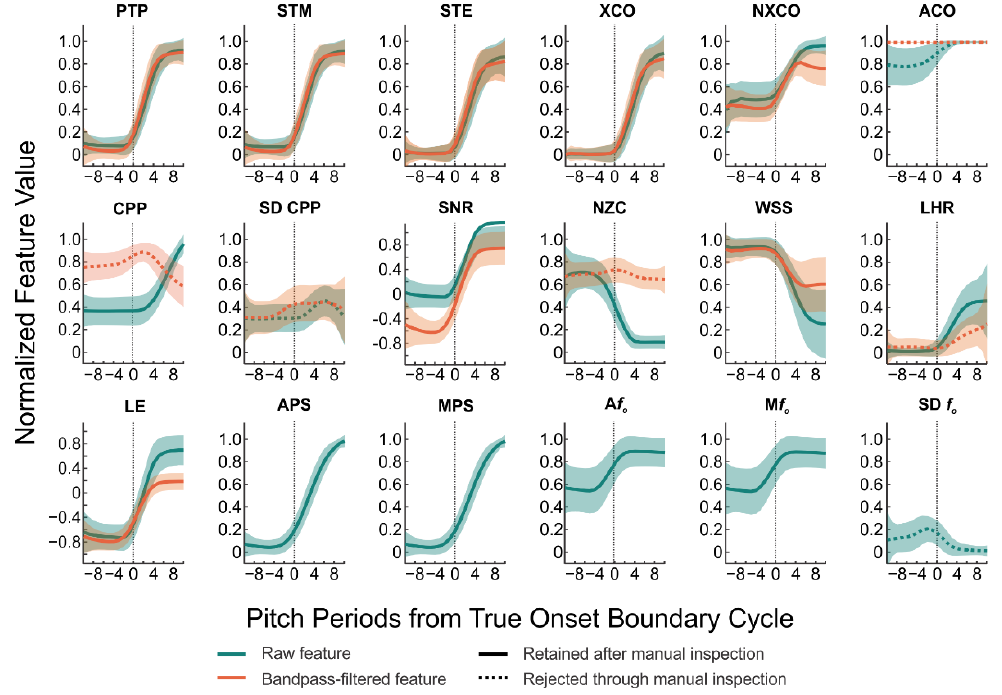
Figure 4. Normalized feature values calculated from the raw microphone signal or Auditory-SWIPE ′ output (teal) with respect to distance (pitch periods) from the true boundary cycle (thin black dotted line) for voicing onset. Normalized feature values calculated from band-pass filtered microphone signal are overlaid in orange (when applicable). Top row: normalized peak-to-peak amplitude (PTP), short-time magnitude (STM), short-time energy (STE), cross-correlation (XCO), normalized cross-correlation (NXCO), autocorrelation (ACO). Middle row: mean and standard deviation of cepstral peak prominence (CPP, SD CPP), signal-to-noise ratio (SNR), number of zero crossings (NZC), waveform shape similarity (WSS), low-to-high ratio of spectral energy (LHR). Bottom row: log energy (LE), average and median pitch strength (APS, MPS), average, median, and standard deviation of f o (A f o , M f o , SD f o ). Thick solid lines indicate mean values of features that were retained after manual inspection. Thick orange and teal dashed lines indicate mean values of features that were removed through manual inspection. Shaded regions indicate standard deviation.